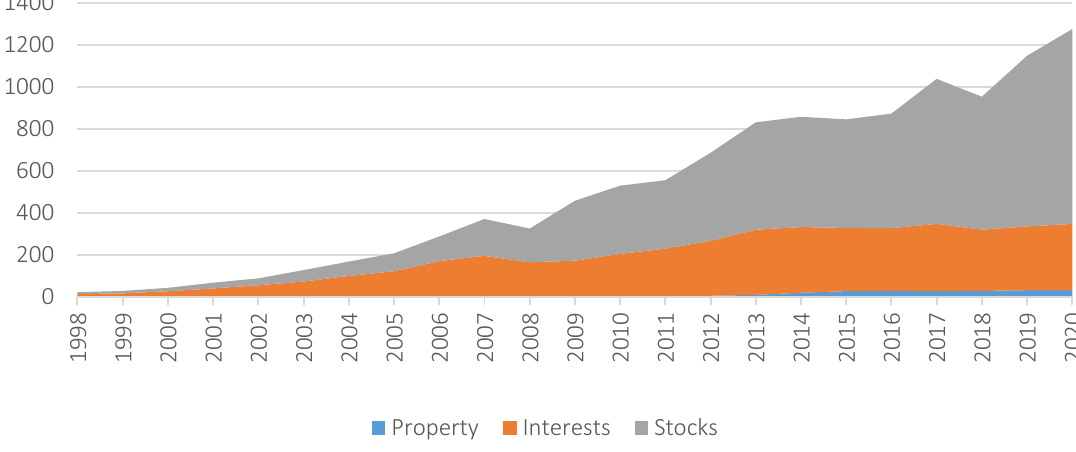
Figure 3. Value of the Norwegian Pension Fund – Global, in USD billion